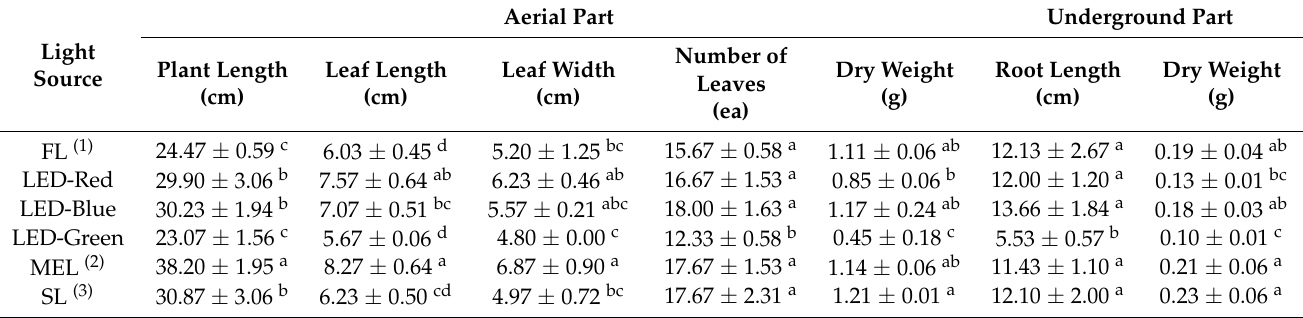
Table 1. Growth characteristics by parts of aerial and underground in Dachul treated with artificial light sources for 2